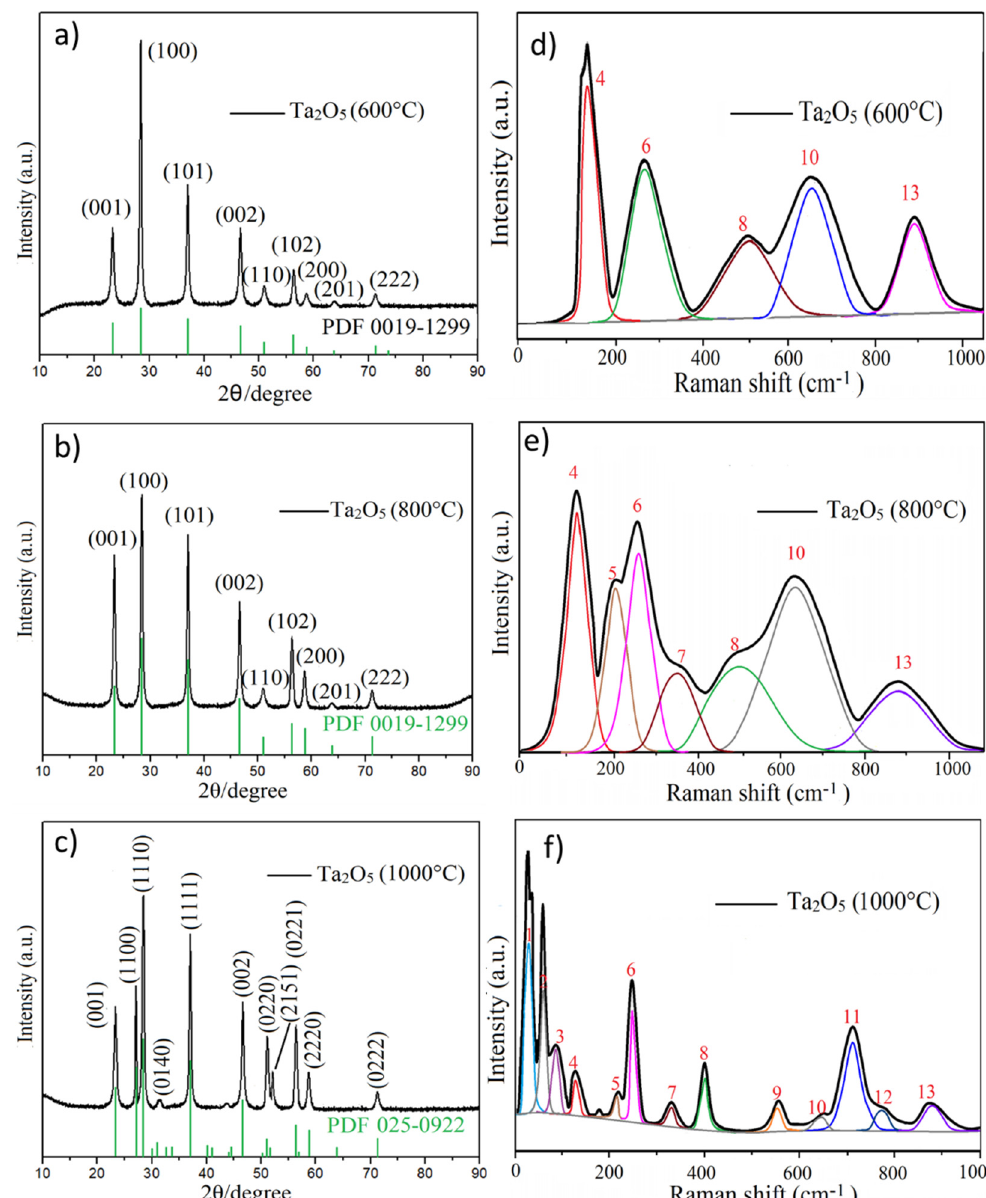
Figure 2. XRD patterns ( a ) and the deconvolution of the Raman spectra ( d ) of prepared Ta 2 O 5 obtained at 600 °C; XRD patterns ( b ) and the deconvolution of the Raman spectra ( e ) of prepared Ta 2 O 5 obtained at 700 °C; XRD patterns ( c ) and the deconvolution of the Raman spectra ( f ) of prepared Ta 2 O 5 obtained at 800 °C.